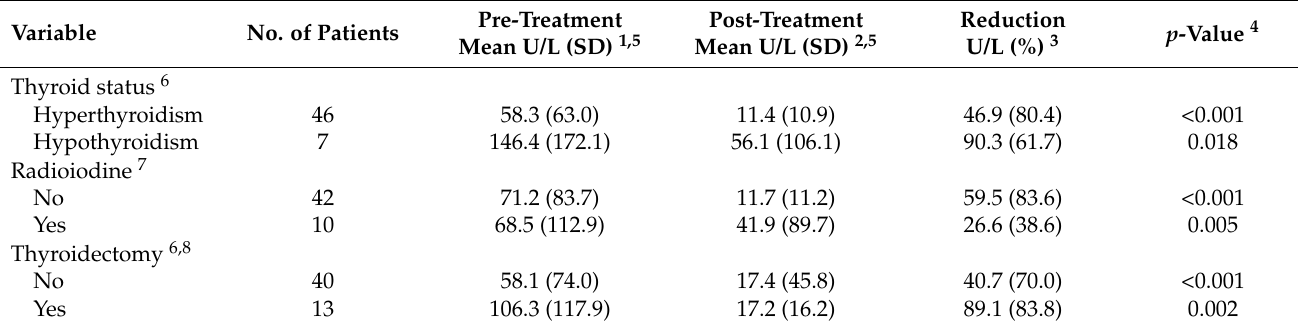
Table 2. Thyrotropin receptor antibody (TRAb) levels before and after treatment with tocilizumab according to thyroid- related baseline